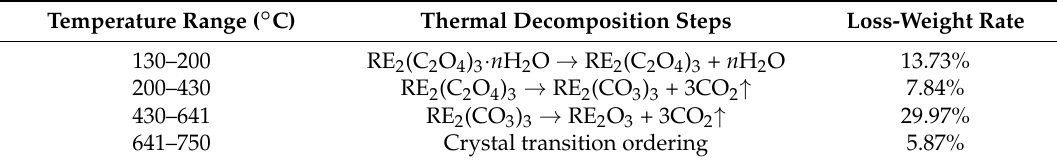
Table 6. Main chemical composition of RE oxides.